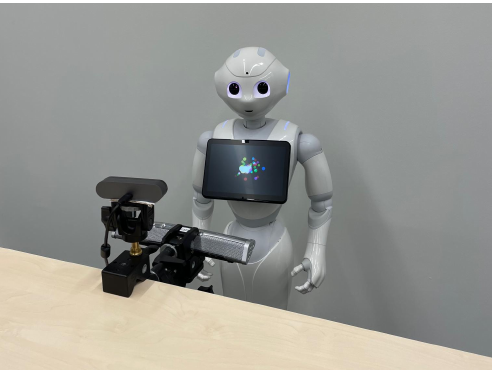
Figure 2. Setup from the MAS lab perspective with the Pepper robot.